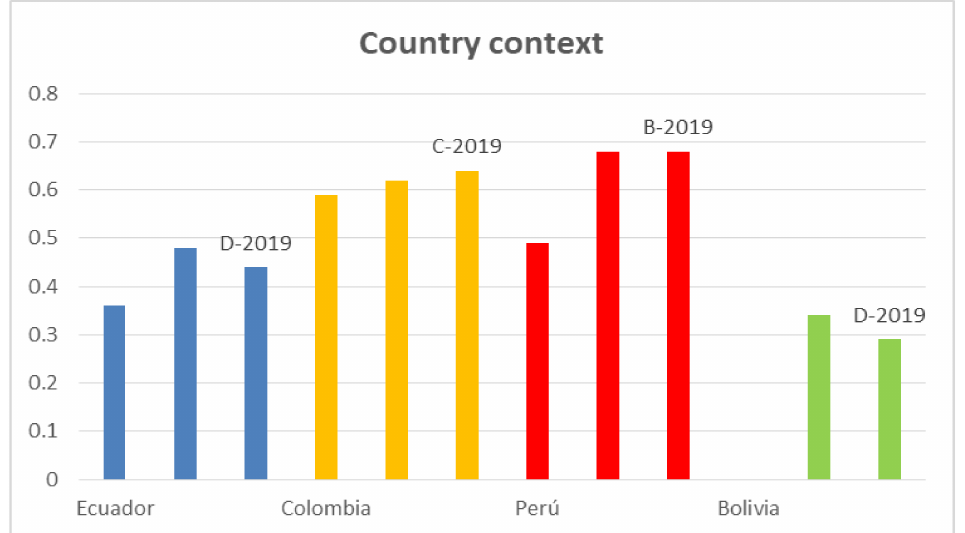
Figure A4. Country context dimension by countries in period from 2017 to 2019. A,B,C,D—letter indices according to the WEC methodology: The letter A indicates the highest grade, the letter D—the lowest for each of the